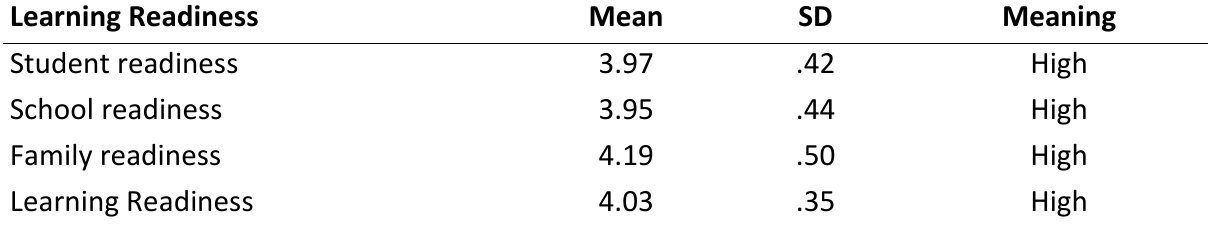
Table 1: Dimension of Learning Readiness among School Students Learning Readiness